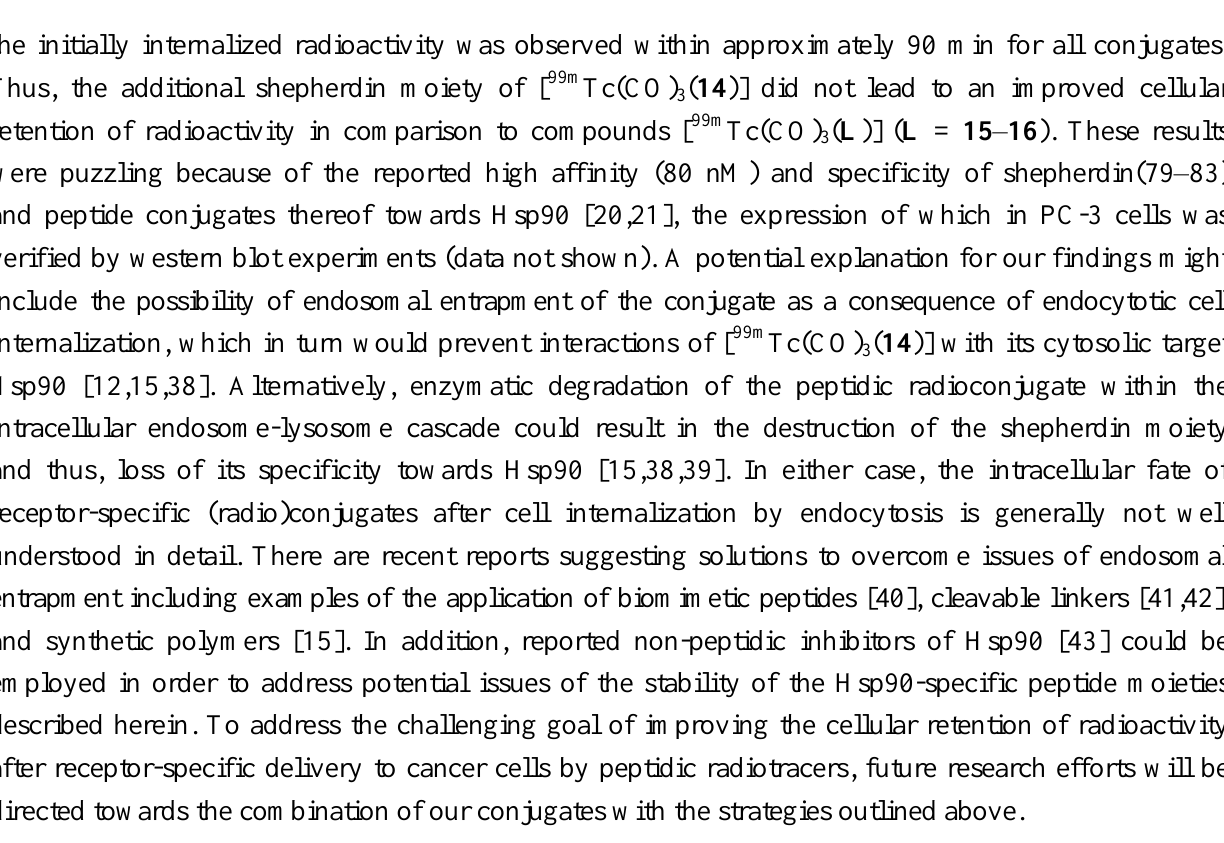
( L )] ( L = 14 – 16 ) from 3 ( 15 )] (∆, dotted line), 3